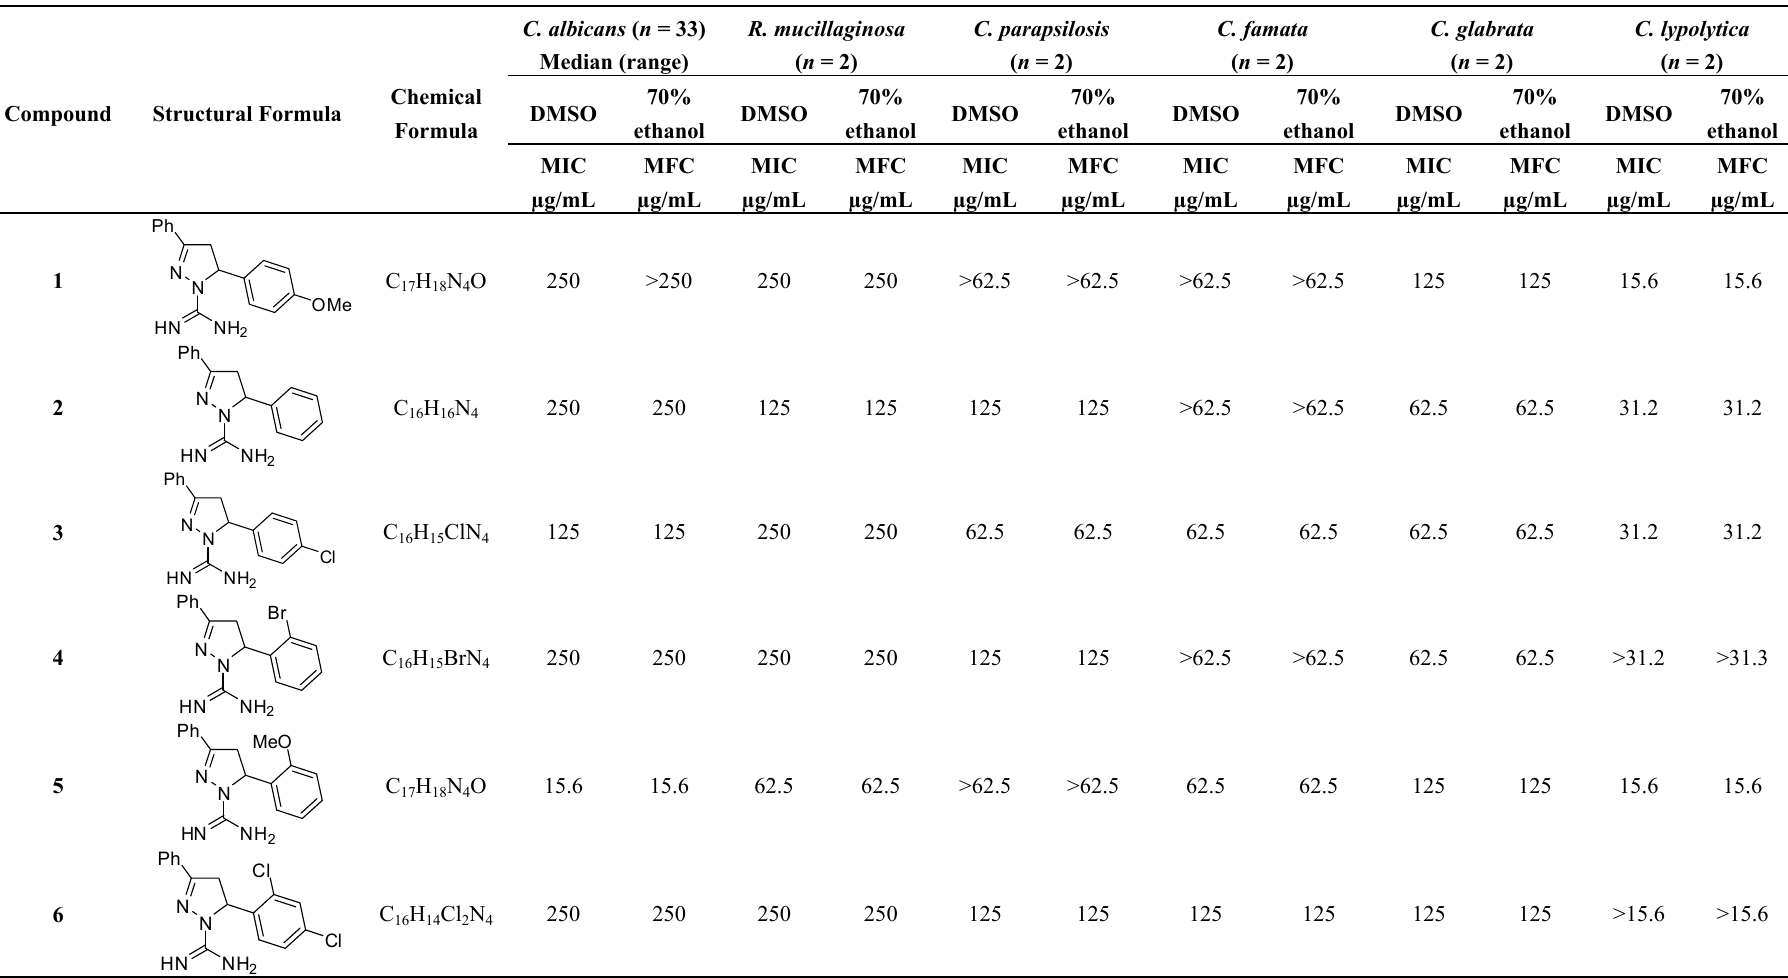
Table 2. In vitro antifungal activity against Candida albicans and non- C.albicans of the pyrazole derivatives dissolved in DMSO or in 70% ethanol.